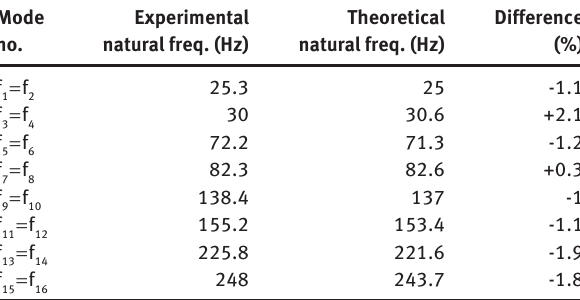
Table 12: Comparison between natural frequencies of truncated cone # 1 (experiment and theory after autoclave treatment).